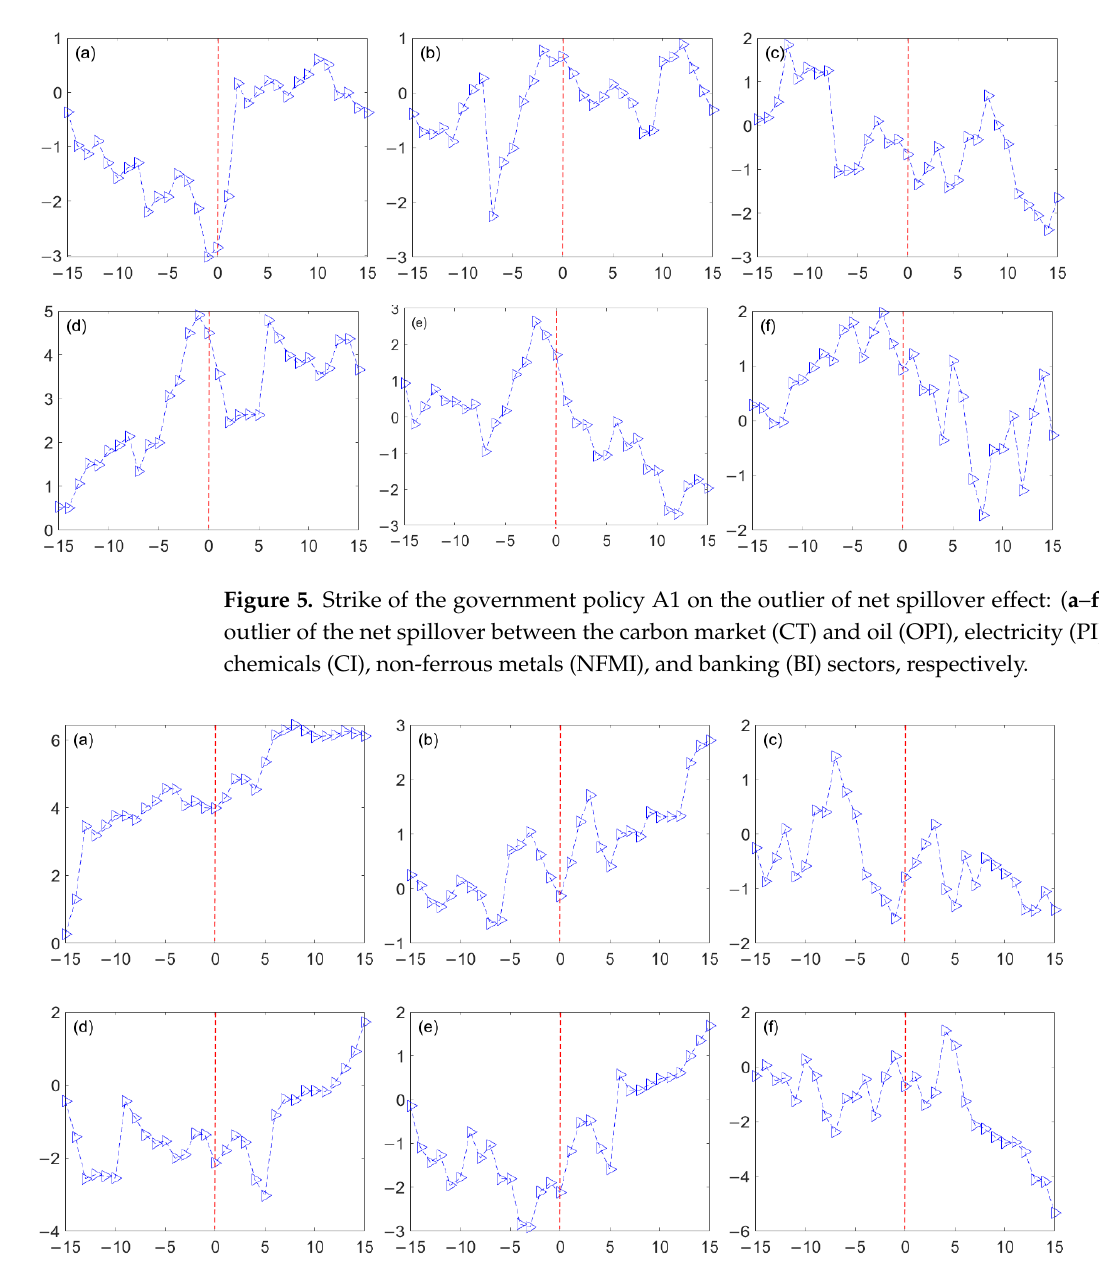
Figure 6. Strike of the government policy A2 on the outlier of net spillover effect: ( a – f ) show the outlier of net spillover between the carbon market (CT) and oil (OPI), electricity (PI), steel (SI), chemicals (CI), non-ferrous metals (NFMI), and banking (BI) sectors, respectively.